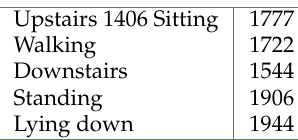
Table 1. HAR data